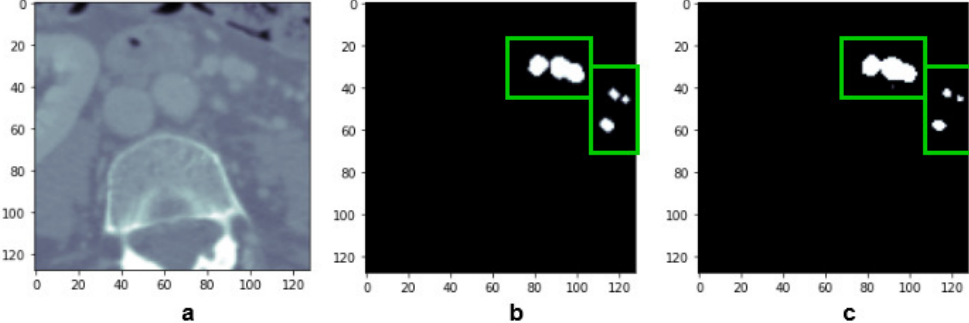
Figure 12. Portal vein sample 5: image ( a ), original mask ( b ) and predicted mask ( c ) after pre- processing with